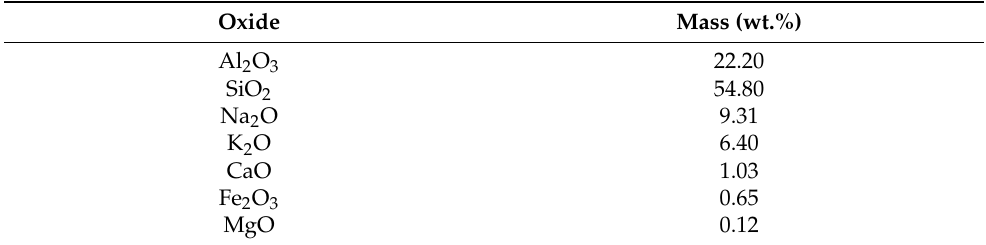
Table 1. Chemical analysis of nepheline syenite sample used in this